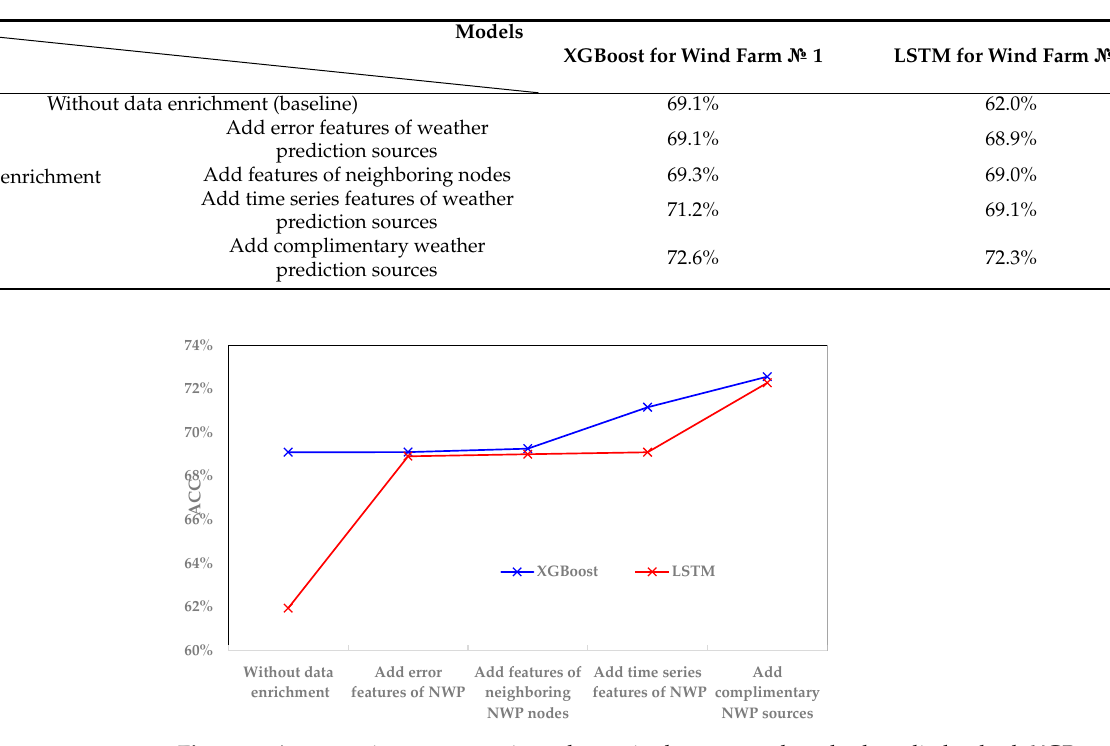
Table 7. Forecast accuracy of the wind power forecasting models with the addition of each step in the data enrichment method for wind farm № 1.